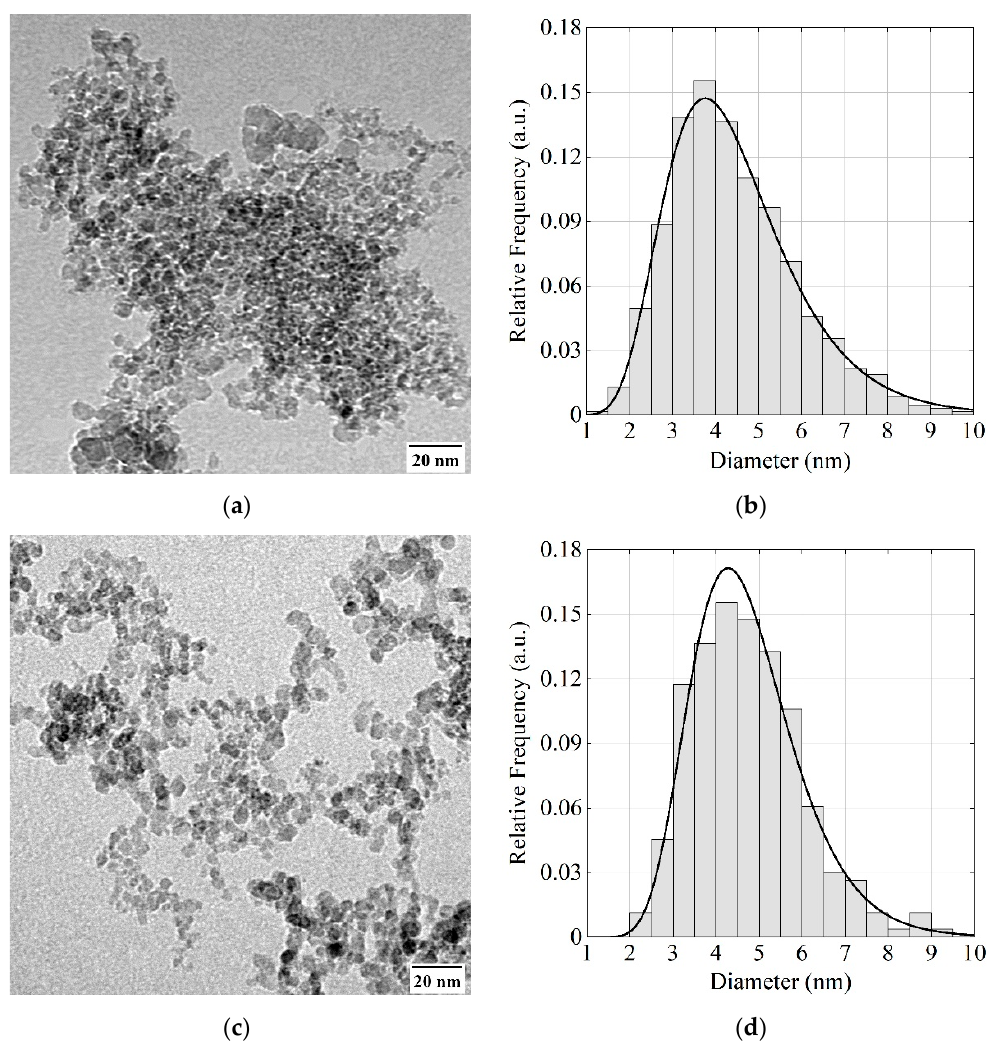
Figure 2. ( a , c ) TEM images of the F-DND and DF-DND samples; ( b , d ) respective diameter distribu- tions of the DNDs. Black solid lines correspond to the lognormal distribution.